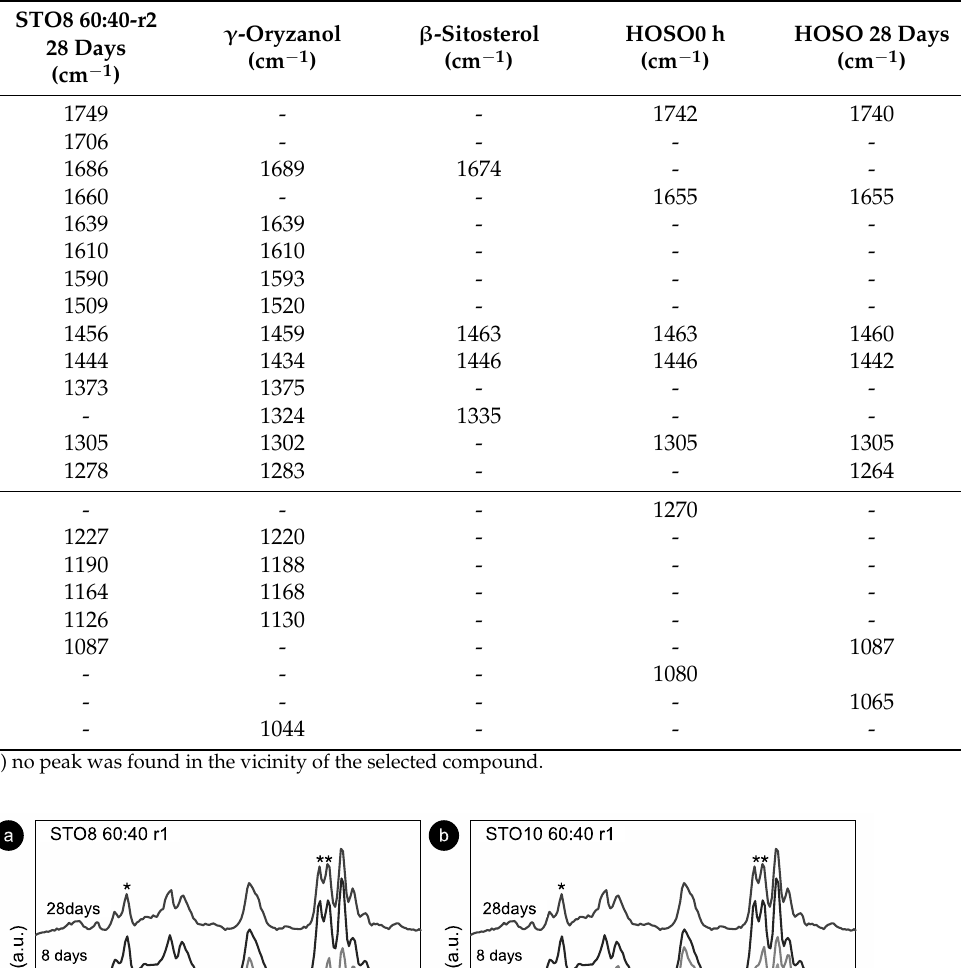
Table 1. Registered peaks for the Raman Spectra of STO8 60:40-r2 at 28 days, γ -oryzanol and β -sitosterol powders, and the HOSO sample at 0 h and at 28 days.